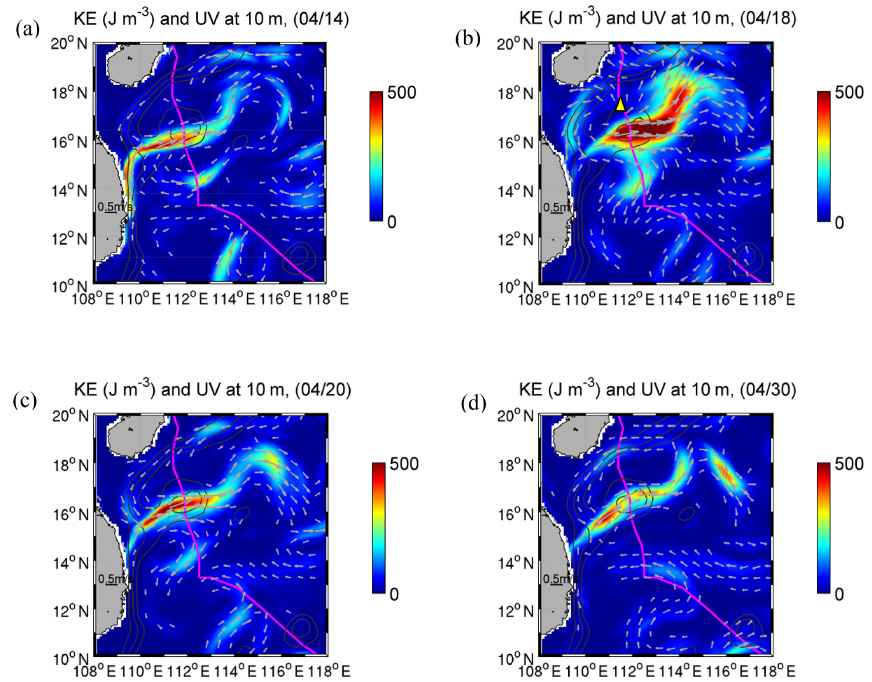
Figure 2. Daily mean KE (Jm − 3 , colour contour) and current vectors (arrows) at 10m (a) on 14 April of the pre-storm stage (PS), (b) on 18 April during the strongest wind forcing of the forced stage (FS), (c) on 20 April after the end of the FS, and (d) on 30 April during the relaxation stage (RS). The grey contours are the 200, 500, and 1000m isobaths. The magenta line represents TC track. Yellow triangle on 18 April represents the TC location. The TC was located beyond the plotting domain during the other 3d, as shown in Fig. 1a. The velocity magnitudes < 0 . 2ms − 1 are not shown in the